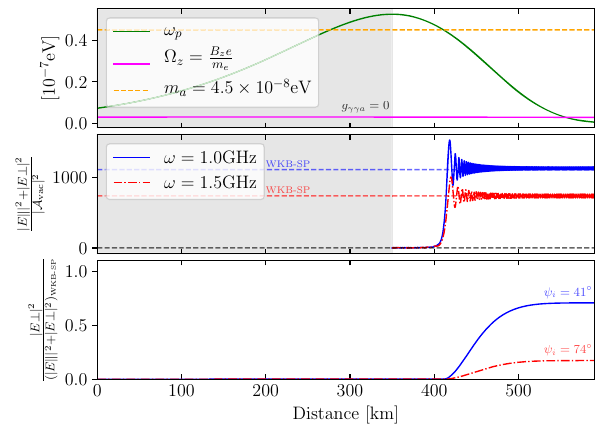
Fig. 3 Top panel: ω p and Ω z profile in the ionosphere, assuming a Chapman layer profile [54,55] with a plausible maximum free electron density n max e = 2 × 10 6 cm − 3 , along with the axion mass chosen in the simulation. Central panel: electric field squared amplitude, normalized to the vacuum axion–photon conversion squared amplitude. In dashed, we show the result using the analytical approximation given by Eq. (2). The dashed gray line corresponds to the vacuum conversion squared amplitude. In the shaded gray region, we have switched off the axion– photon coupling in order to show only the propagation of the second resonant burst. Bottom panel: squared component of the electric field perpendicular to the Earth magnetic field, generated via Faraday rota- tion. We have normalized it to the total squared amplitude as given by Eq. (2)